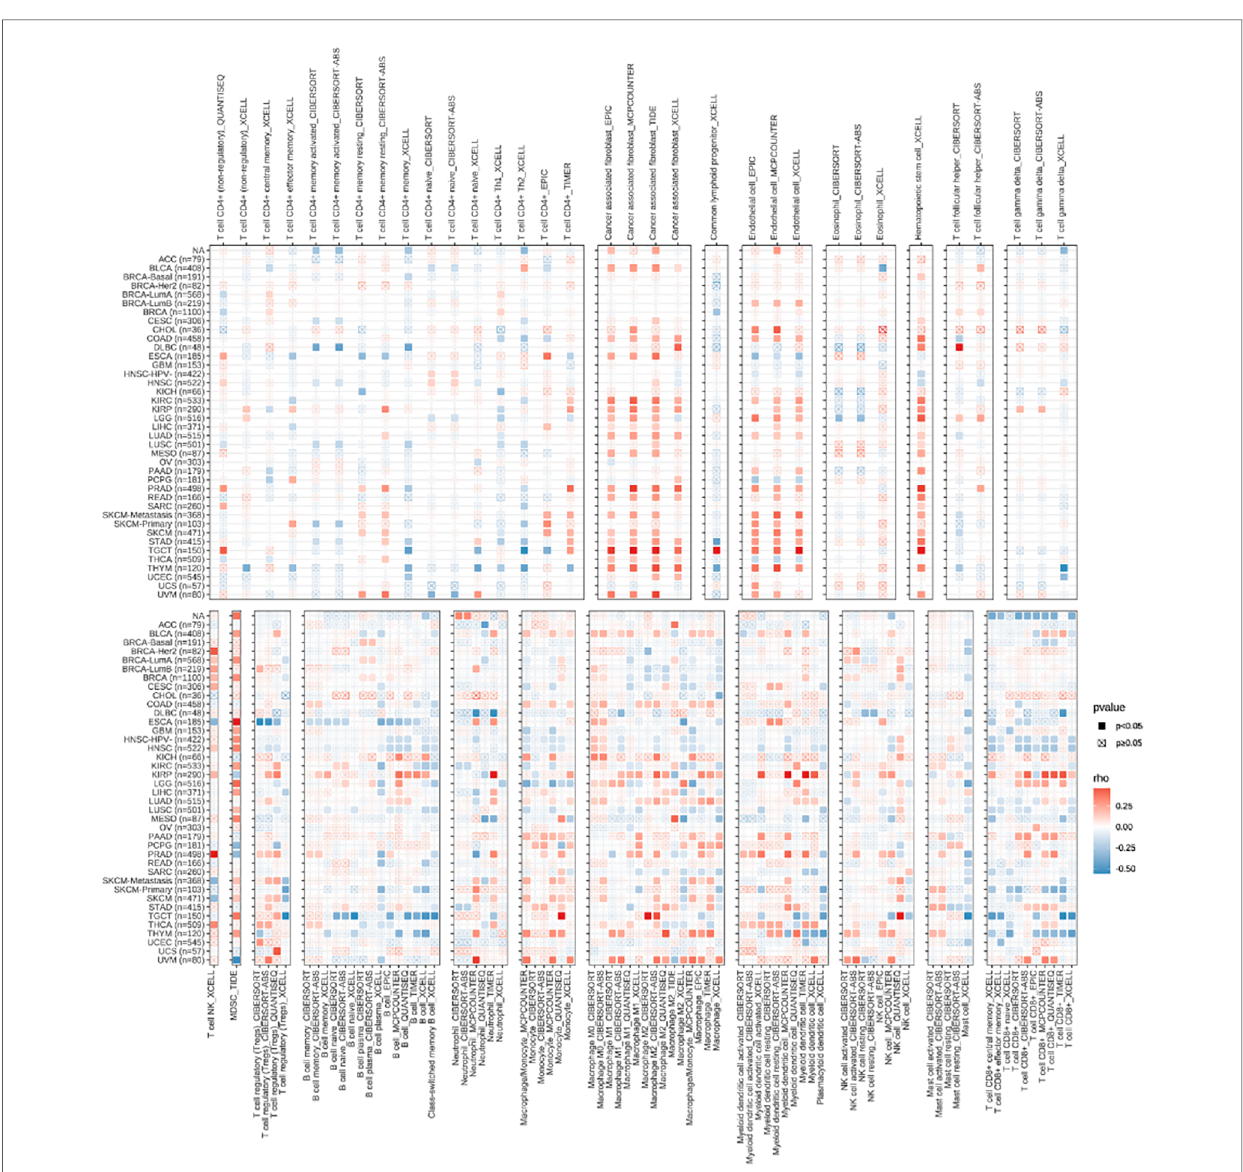
FIGURE 9 The relationships between RBP1 expression and the amount of immune cell in fi ltration in